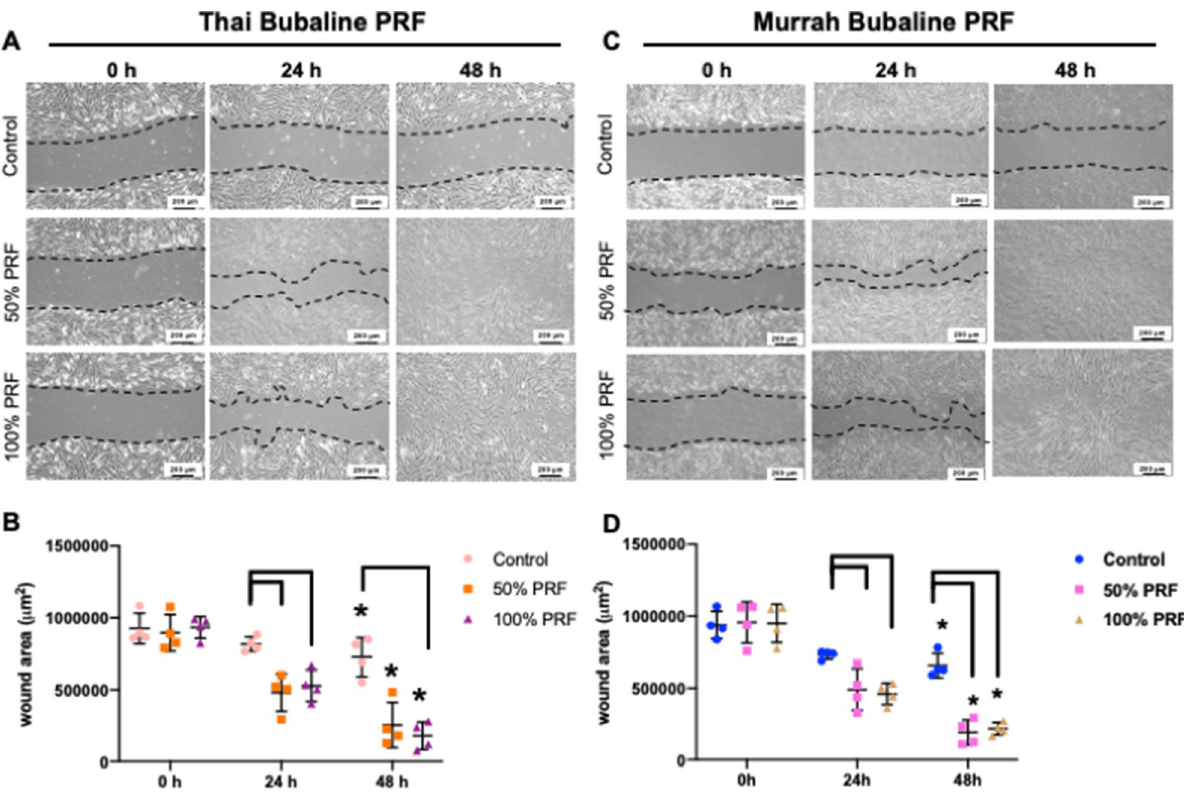
Figure 4. Bubaline blood derived platelet rich fibrin (PRF) induced cPDLs migration. The scratch assay was employed for cell migration study. Cells were maintained in serum free medium with the supplementation of 50% or 100% PRF extracts. The representative images of cPDLs migration were demonstrated ( A and C ). The scratch defect area was determined using ImageJ software. The graph demonstrated the remaining wound area ( B and D ). Bars indicated the statistically significant difference. Asterisks indicated the statistically significant difference compared with the same condition at 0 h. (Kruskal–Wallis test with Dunn’s multiple comparisons test, p <